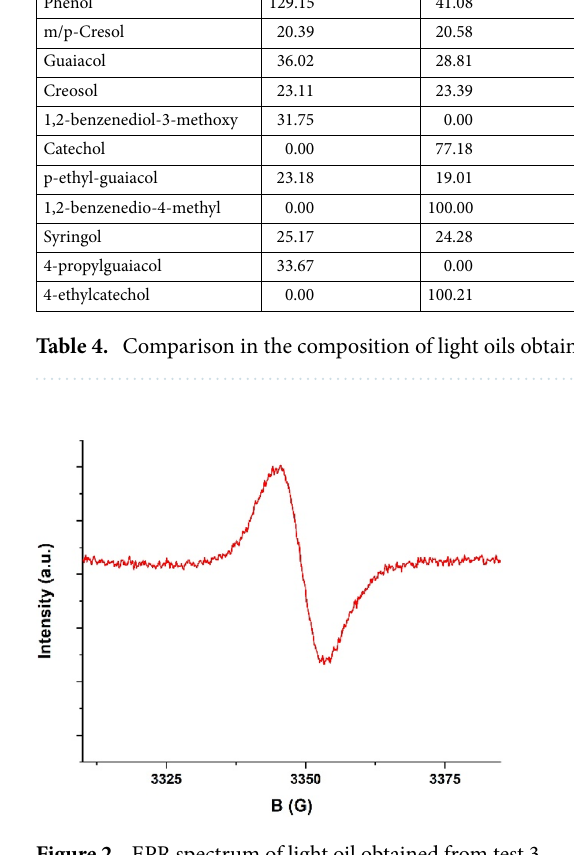
Figure 2. EPR spectrum of light oil obtained from test 3.